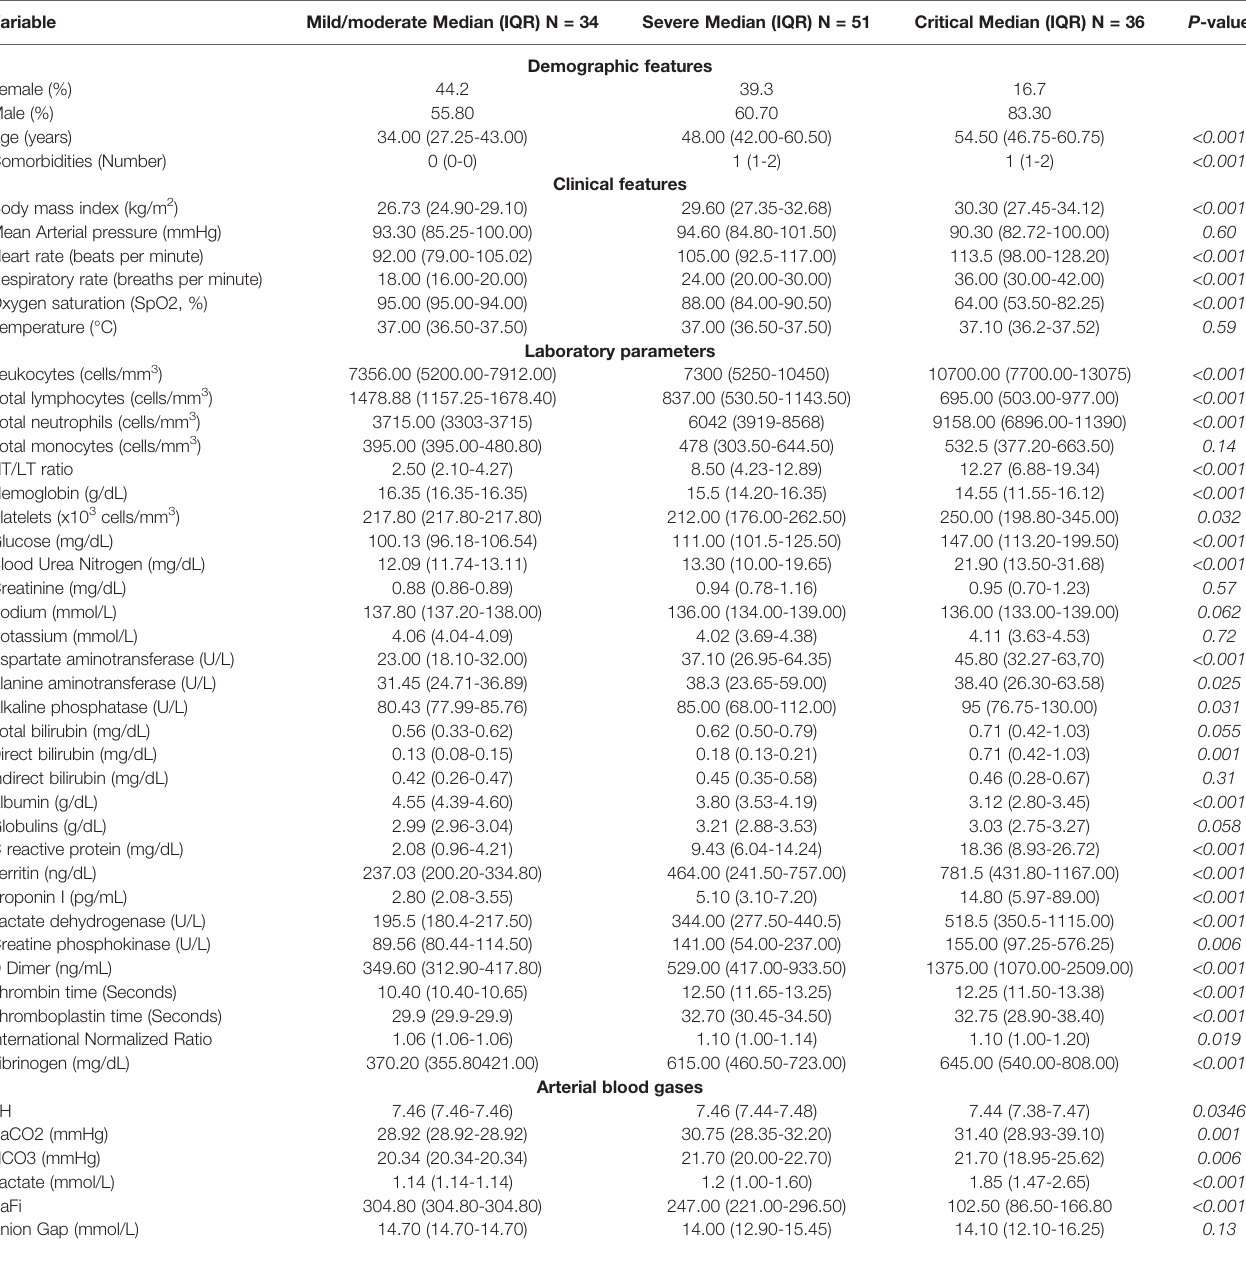
TABLE 1 | Clinical features of patients with COVID-19 according to disease severity.